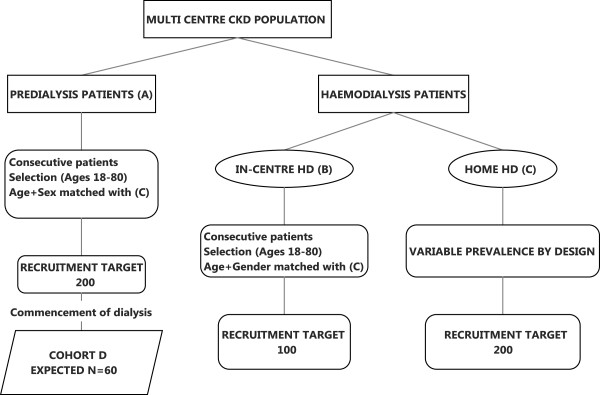
Schema of recruitment size and population.